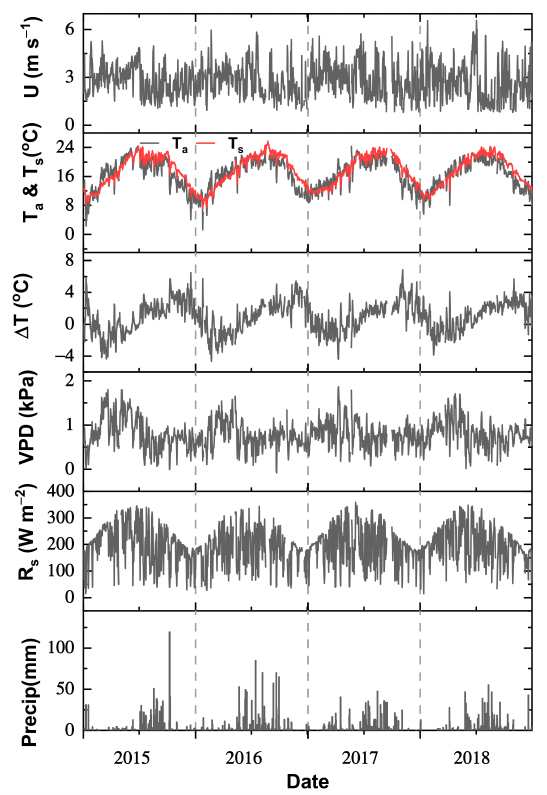
Figure 2. Daily average of wind speed ( U ), air temperature ( T a ), water surface temperature ( T s ), temperature di ff erence ( ∆ T ), vapor pressure di ff erence (VPD), incoming solar radiation ( R s ), and